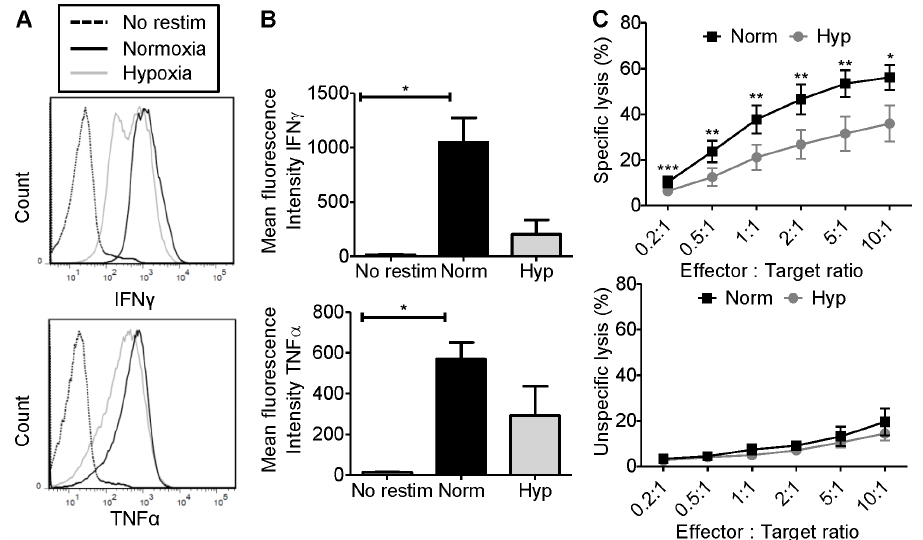
Figure 4. Hypoxia suppresses CD8 T cell effector function. (A) Representative histogram plots for the mean fluorescence intensity of IFN c (top panel) and TNF a (bottom panel) produced by CD8 T cells cultured under normoxic conditions or 1.5% oxygen. (B) The average geometric mean fluorescence and standard error of the mean for 3 independent experiments is shown. Statistical significance was determined by paired t-tests. (C) OT-I T cells were co-cultured with E.G7 (top panel) or EL4 (bottom panel) target cells at various effector:target ratios for 4 hours under normoxia (norm) or 1.5% oxygen (hyp). The mean and standard error of the mean of 4 or 5 independent cytotoxicity experiments is shown. Statistical significance was determined by paired t-tests on log transformed values. * p , 0.05, ** p , 0.01, *** p , 0.001.